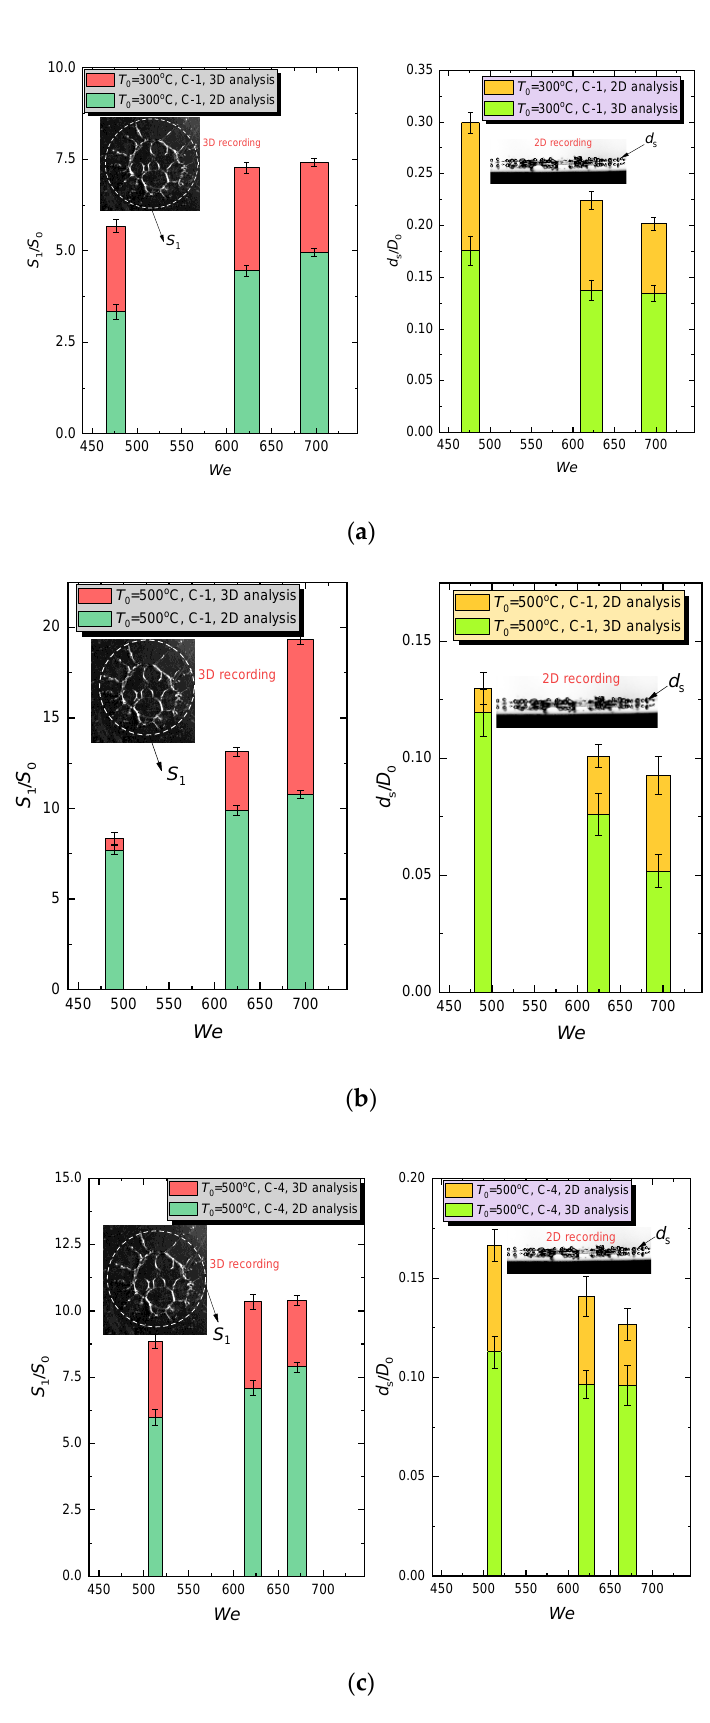
Figure 12. Comparison of integral characteristics of hydrodynamic disintegration for 2D and 3D recording: ( a ) C-1, T 0 = 300 °C; ( b ) C-1, T 0 = 500 °C; ( c ) C-4, T 0 = 500 °C.